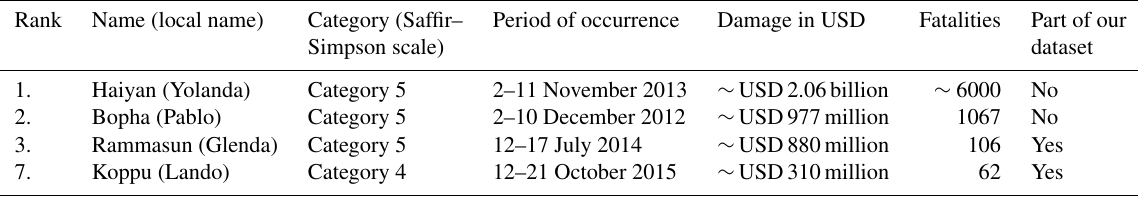
Table 1. Costliest typhoons in the Philippines. Two devastating typhoons, Rammasun and Koppu (ranking 3 and 7), occurred during our study period and made landfall. Damage in US dollars (USD) based on each time of TC occurrence (not adjusted to current inflation